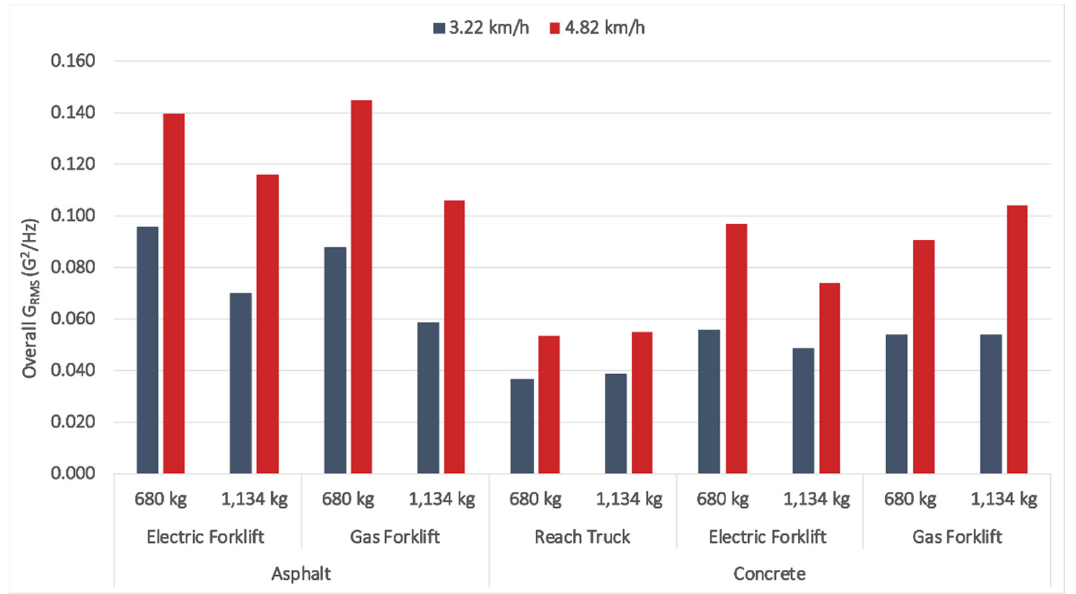
Figure 5. Overall vibration intensity measured at the tip of the fork tines for each of the three forklifts (1–200 Hz).